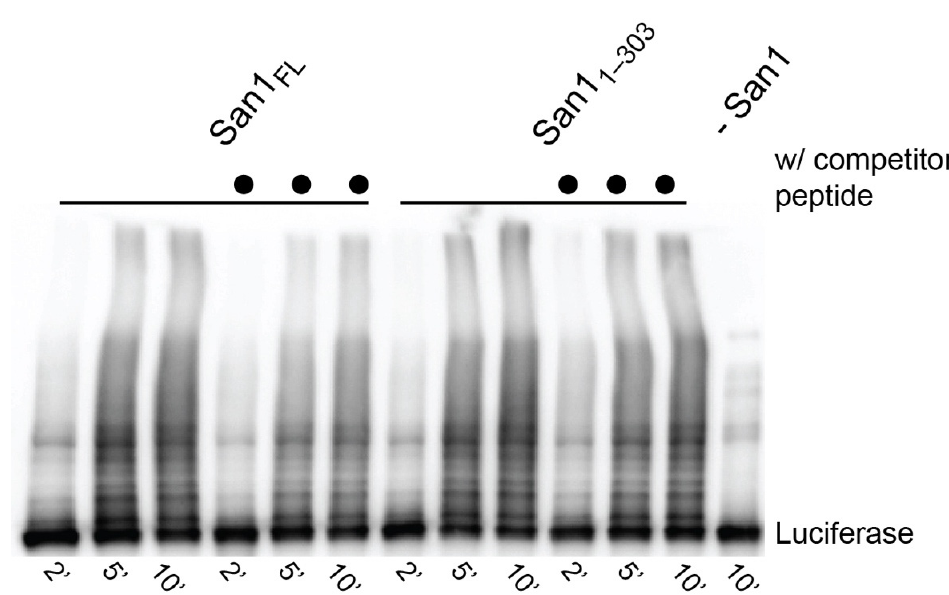
Figure 6. San1 substrate binding sites display specificity. Multi-turnover ubiquitylation reactions between full-length San1 or San 1–303 and heat-denatured luciferase substrate. To assess substrate specificity, San1 was pre-incubated with unlabeled KR peptide substrate prior to the addition of luciferase (lanes 4–6 and 9–12, San1 or San 1–303 , respectively).